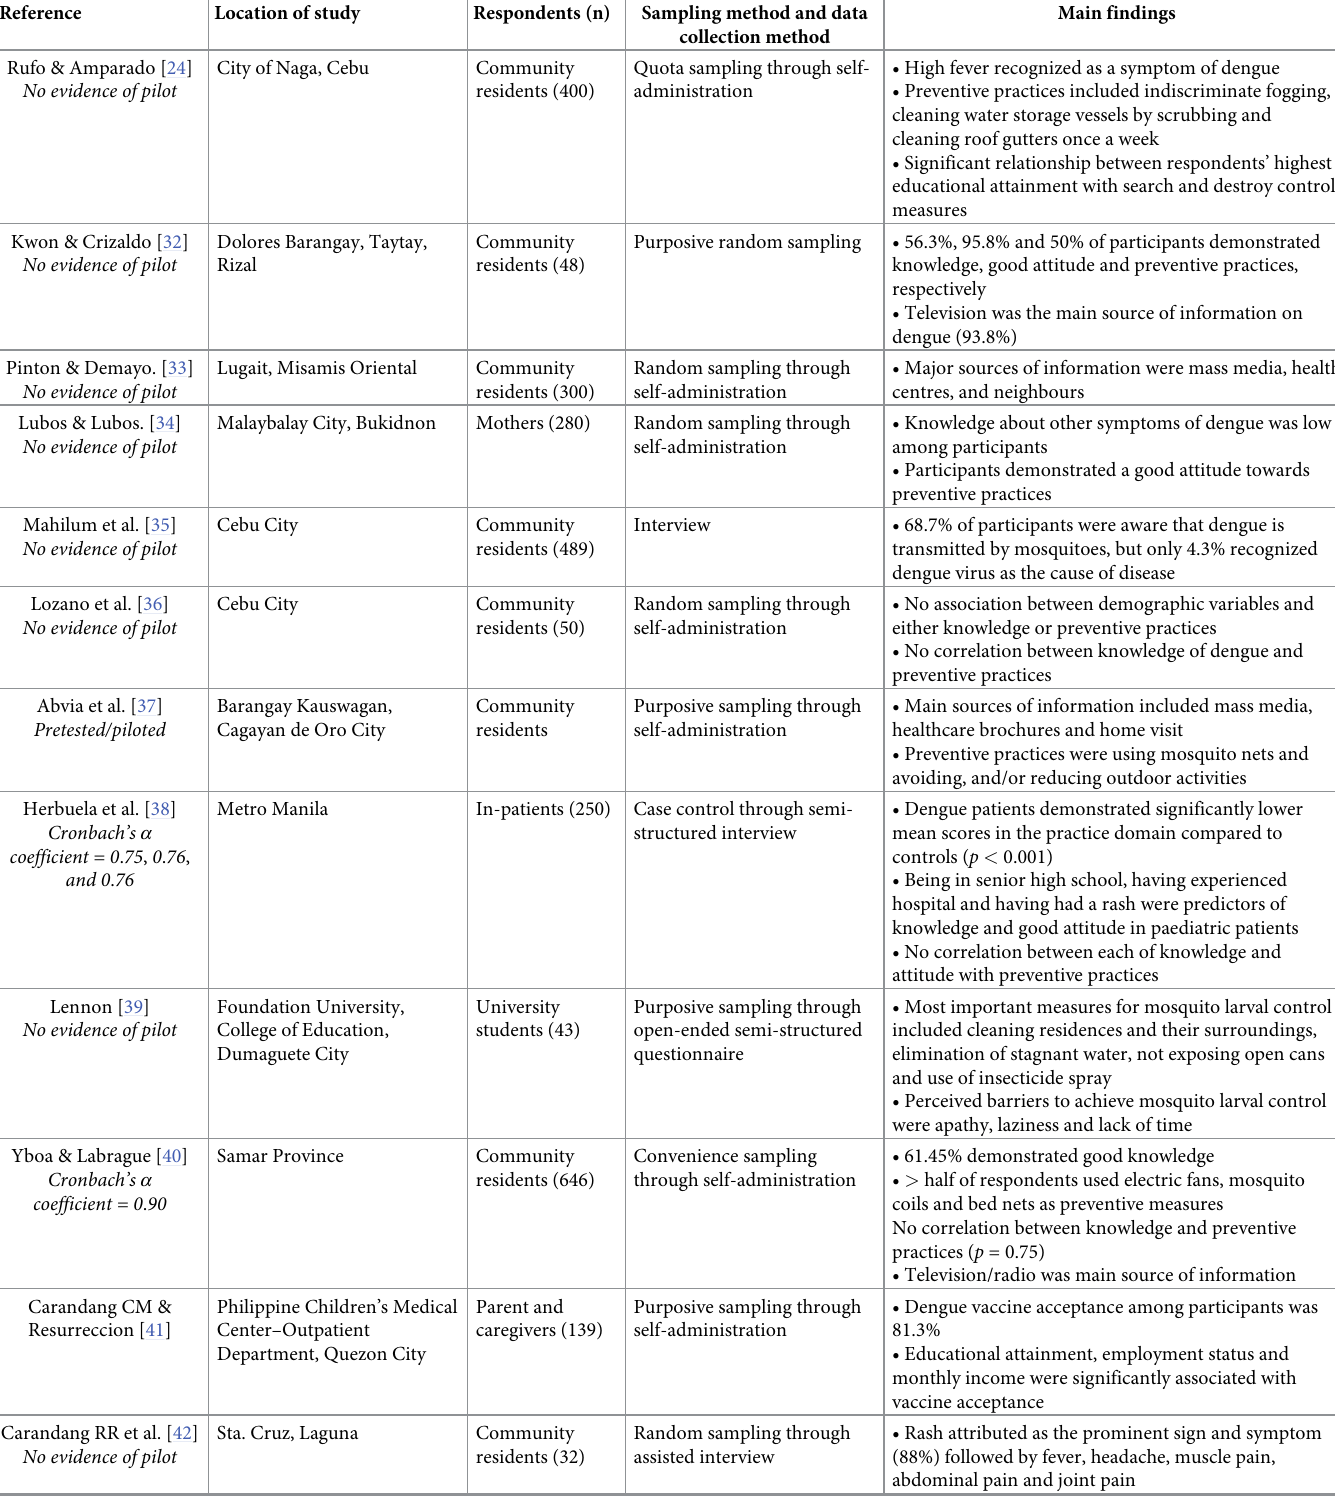
Table 1. List of published questionnaires-based dengue studies in the Philippines, 2004–2020.